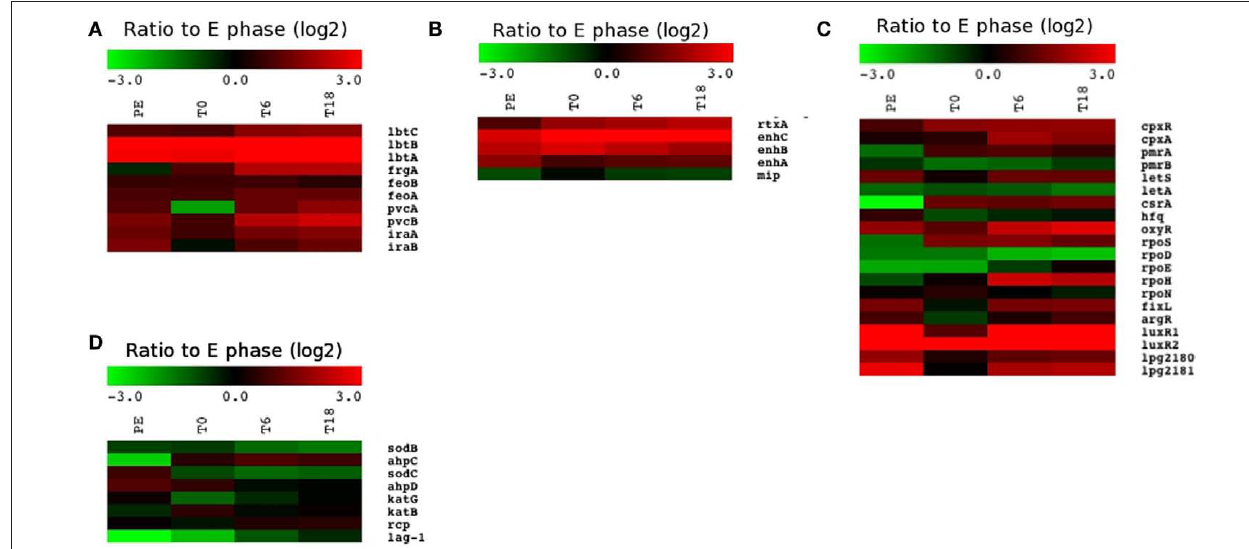
FIgURe 7 | Relative expression of genes involved in various functions. Heat map of the expression ratio to E phase of (a) genes involved in iron acquisition, (B) known virulence factors other than the Icm/Dot system, (C) genes encoding regulators, and (D) genes encoding proteins involved in defense mechanisms against oxidative stress and